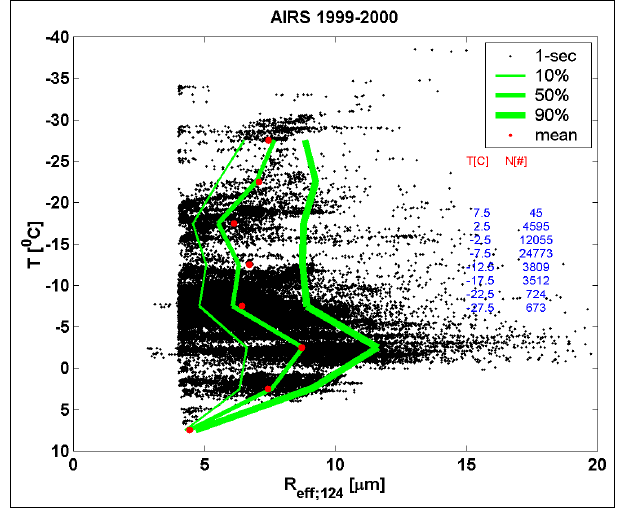
Fig. 6. Effective size as a function of temperature. The number of points is also shown on the figure.